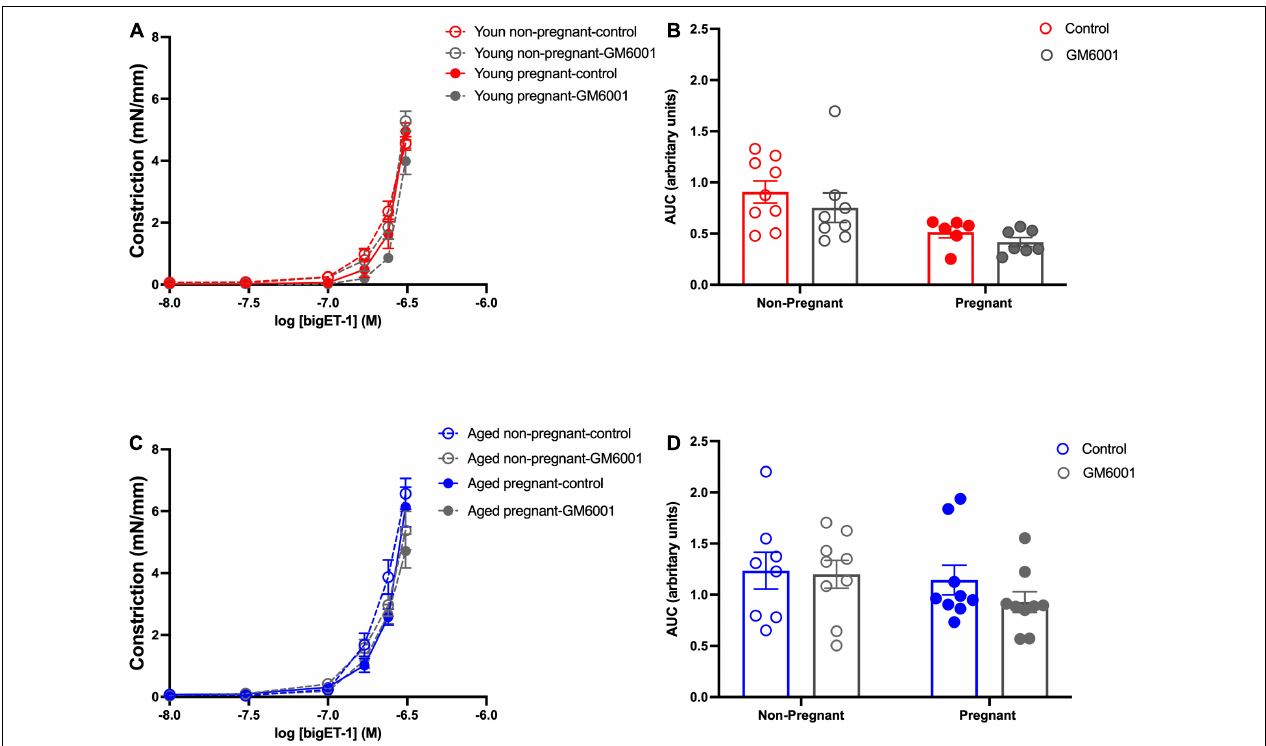
FIGURE 7 | No significant contribution of matrix metalloproteases in converting to bigET-1 in young and aged non-pregnant and pregnant rats. (A,C) Vascular contraction response to bigET-1 in the presence or absence of MMPs inhibitor GM6001 in mesenteric arteries of young [3–4 months; in red; (A,B) ] and aged [9–9.5 months; in blue; (C,D) ] pregnant (on gestational day 20; closed circles) and non-pregnant (age-matched; open circles) rats. (B,D) Data summaries of area under the curve (AUC) of the bigET-1 responses. Data are presented as mean ± SEM; analyzed by two-way ANOVA with Sidak’s multiple comparisons post hoc test; n =